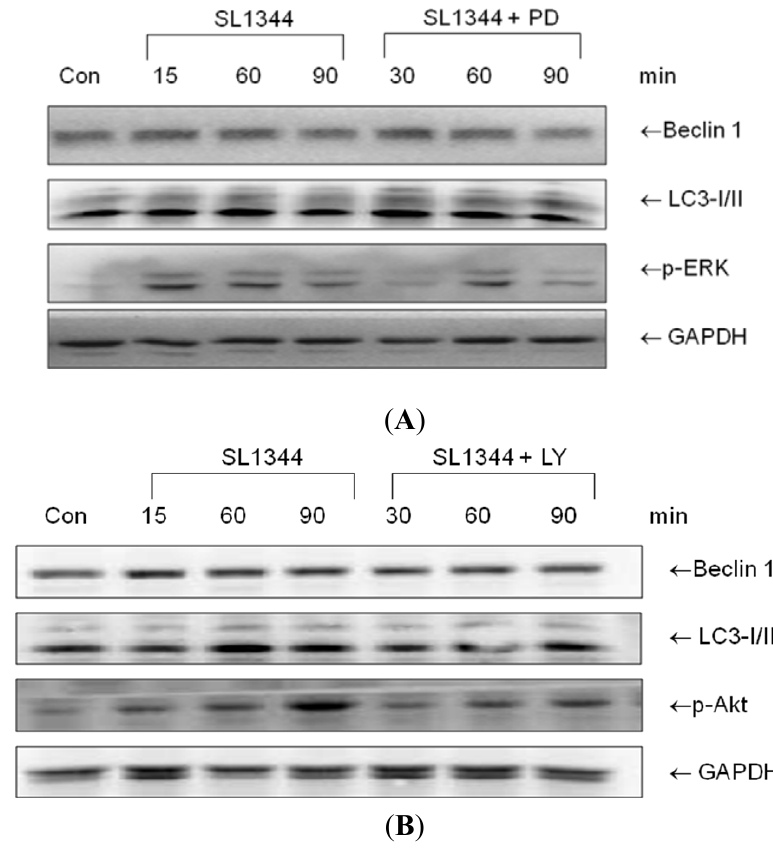
Figure 2. The role of ERK or Akt on the Beclin 1 and LC3II proteins expression in Salmonella -infected Caco-2 cells. Caco-2 cells were uninfected (Con) or infected by wild-type S . typhimurium strain SL1344 for indicated times, in the presence or absence of PD98059 (PD) or LY294002 (LY). Immunoblots were performed on whole cell lysates with antibody to detect Beclin 1 and LC3II expression, or GAPDH for normalization of proteins. Representative immunoblots of Beclin 1 and LC3II proteins expression in Salmonella -infected Caco-2 cells in the presence of PD ( A ) or LY ( B ) are